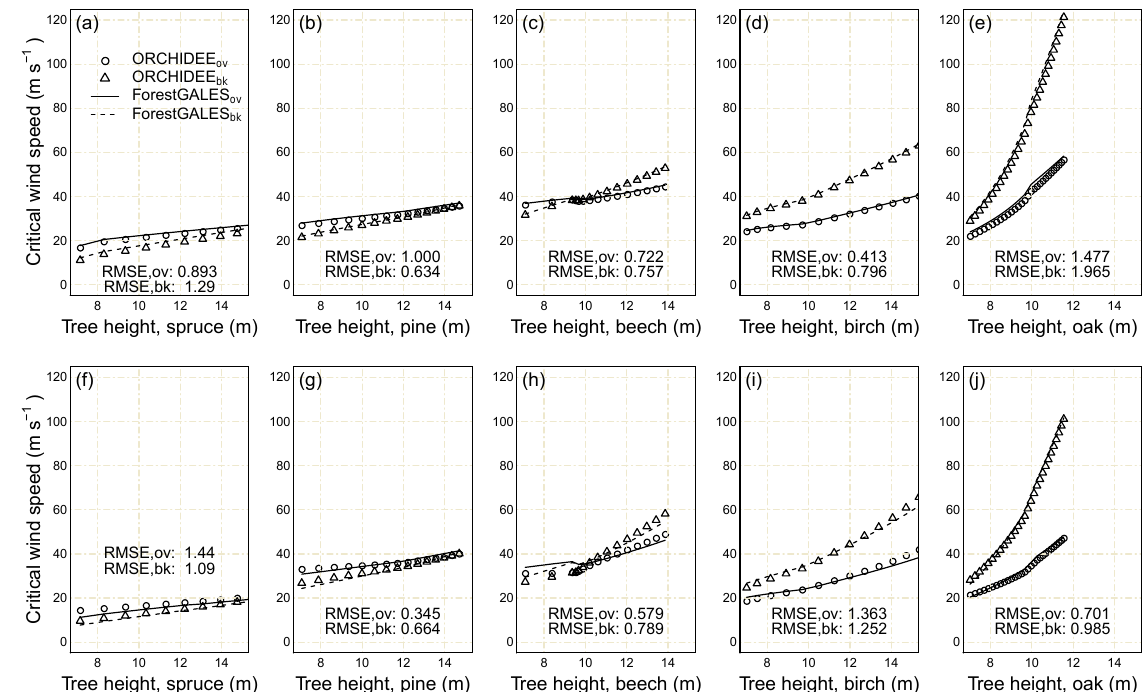
Figure 3. Model-calculated critical wind speeds as a function of tree height for five common tree species in Europe. For each tree species the critical wind speed is calculated for overturning and stem breakage for forest located away from a forest edge (outer, a – e ) and near a forest edge (inner, f – j ). The ORCHIDEE-CAN simulations are shown as symbols and benchmarked against the ForestGALES simulations, which are shown as lines. The scientific names of the tree species are given in Sect. 2.2.3. The CWS differences between the ORCHIDEE-CAN and ForestGALES calculation were calculated using Eq. (11), for which the CWSs from ForestGALES were treated as the